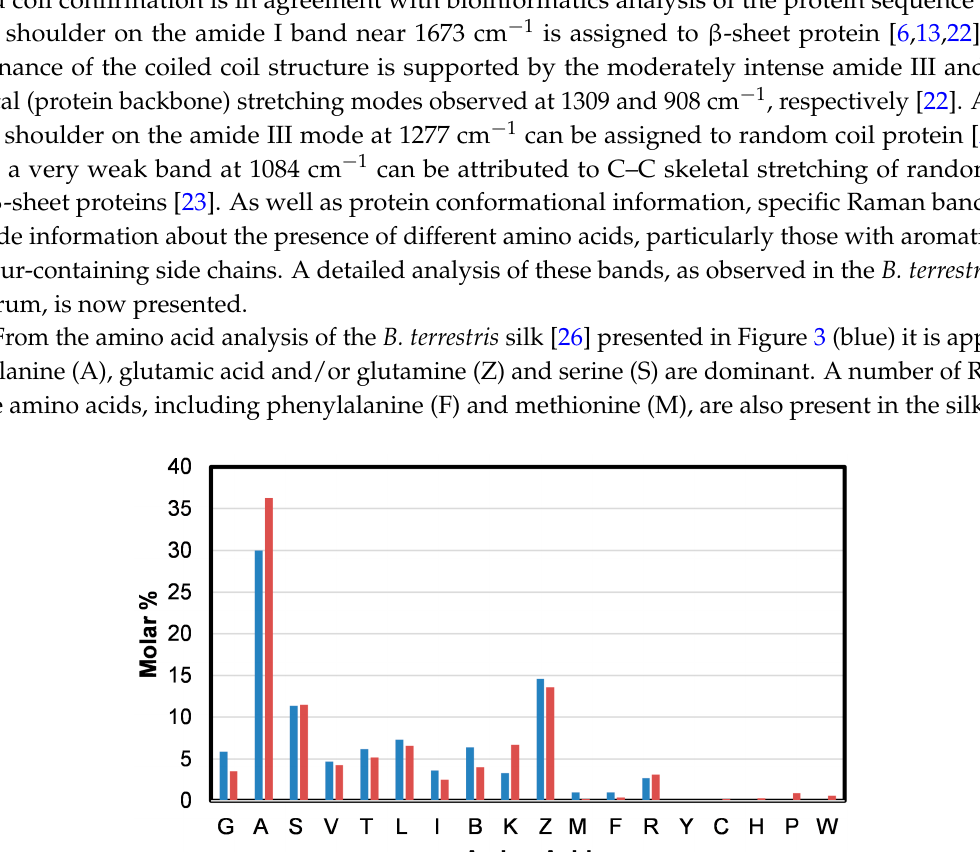
determined from amino acid sequences of the four fibrous B. terrestris silk proteins; BterF1: ABW21694,